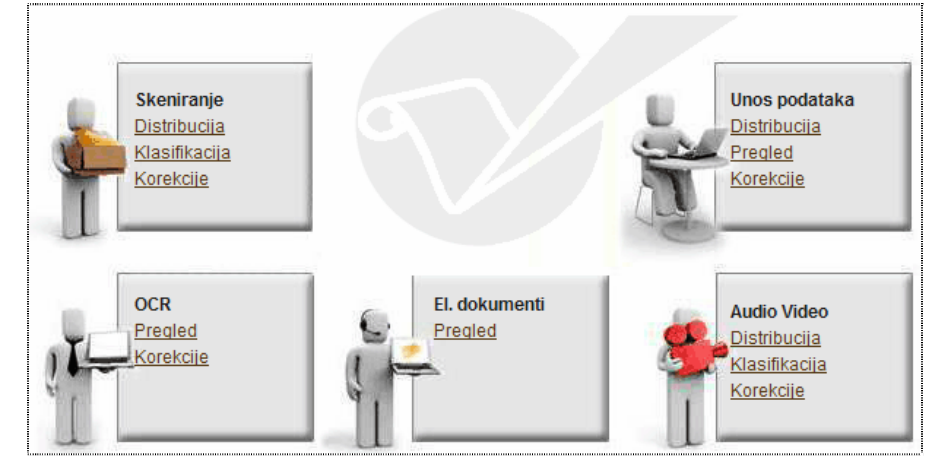
Figure 3 – Partial view of the ADA application for production